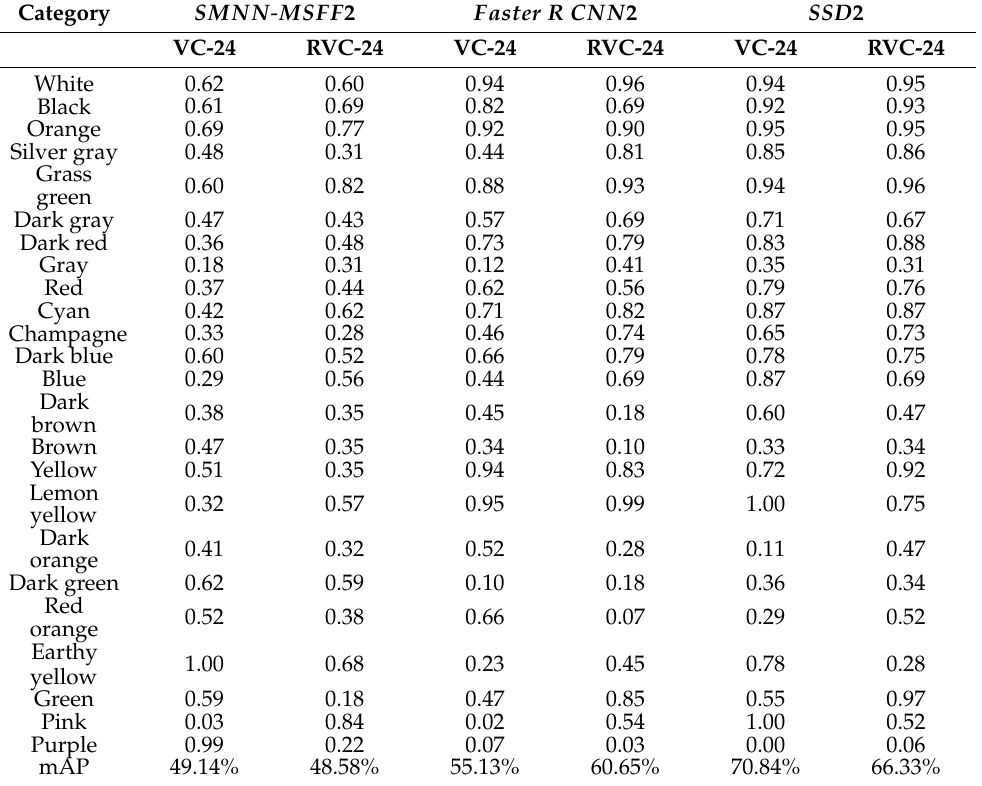
Table 4. Comparison of the average accuracy of each category of object detection algorithms on the Vehicle Color -24 and Rain Vehicle Color -24 test sets. All object detection algorithms are trained on Rain Vehicle Color